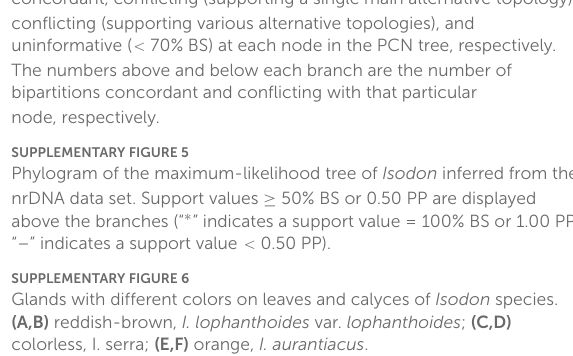
colorless, I. serra; (E,F) orange, I. aurantiacus